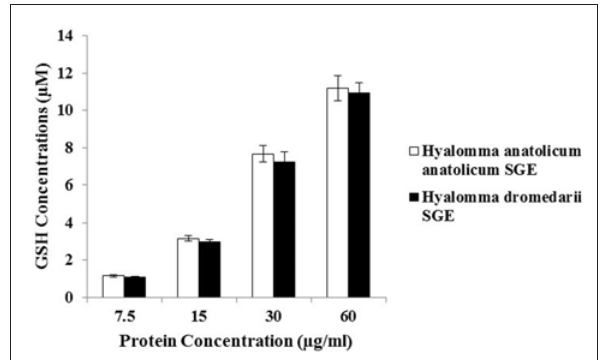
Figure-4: Reduced glutathione concentration in salivary gland extracts of Hyalomma anatolicum anatolicum and Hyalomma dromedarii ticks. Data presented as mean±standard error; N=6 Groups, each group containing six ticks.